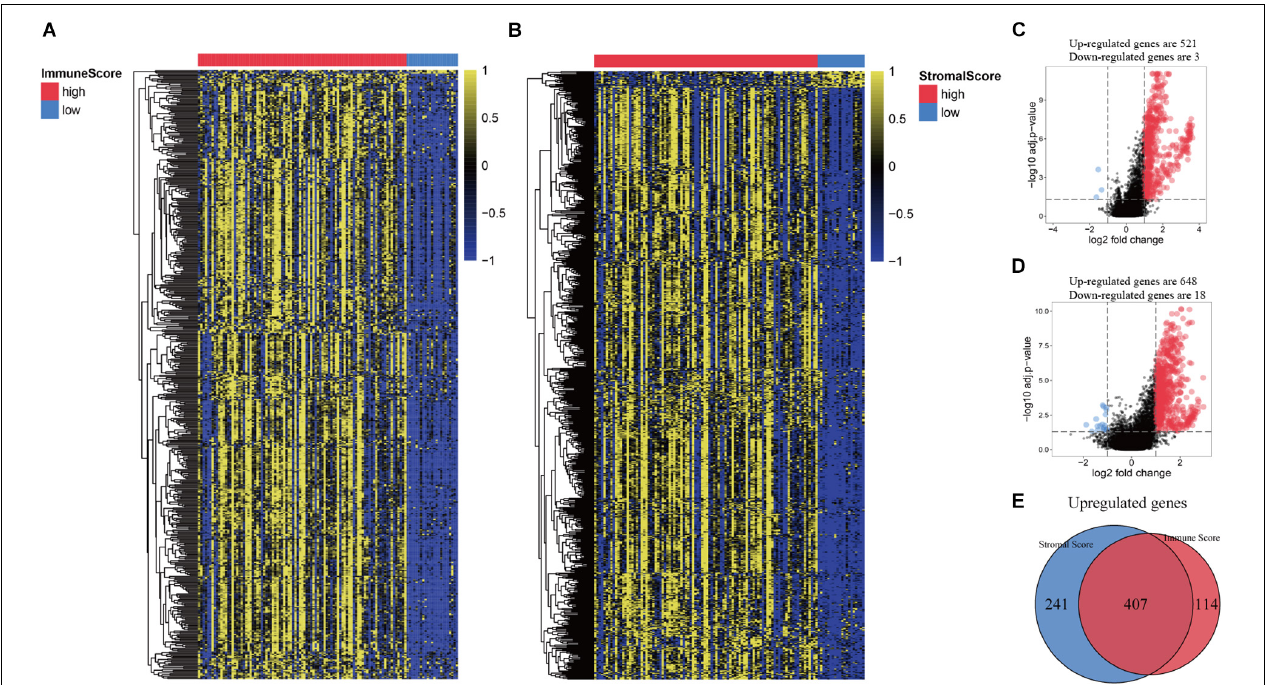
FIGURE 2 | Comparison of gene expression profiles based on immune score and stromal score in recurrent HNSCC. (A) Heat map of genes that are significantly expressed differently based on immune scores. (B) Heat map of genes that are significantly differently expressed based on stromal scores. (C) Volcano map of differential expressed genes (DEGs) according to the immune score. (D) Volcano map of DEGs according to the stromal scores. (E) Venn diagram analysis of abnormally expressed genes according to the immune and stromal scores.